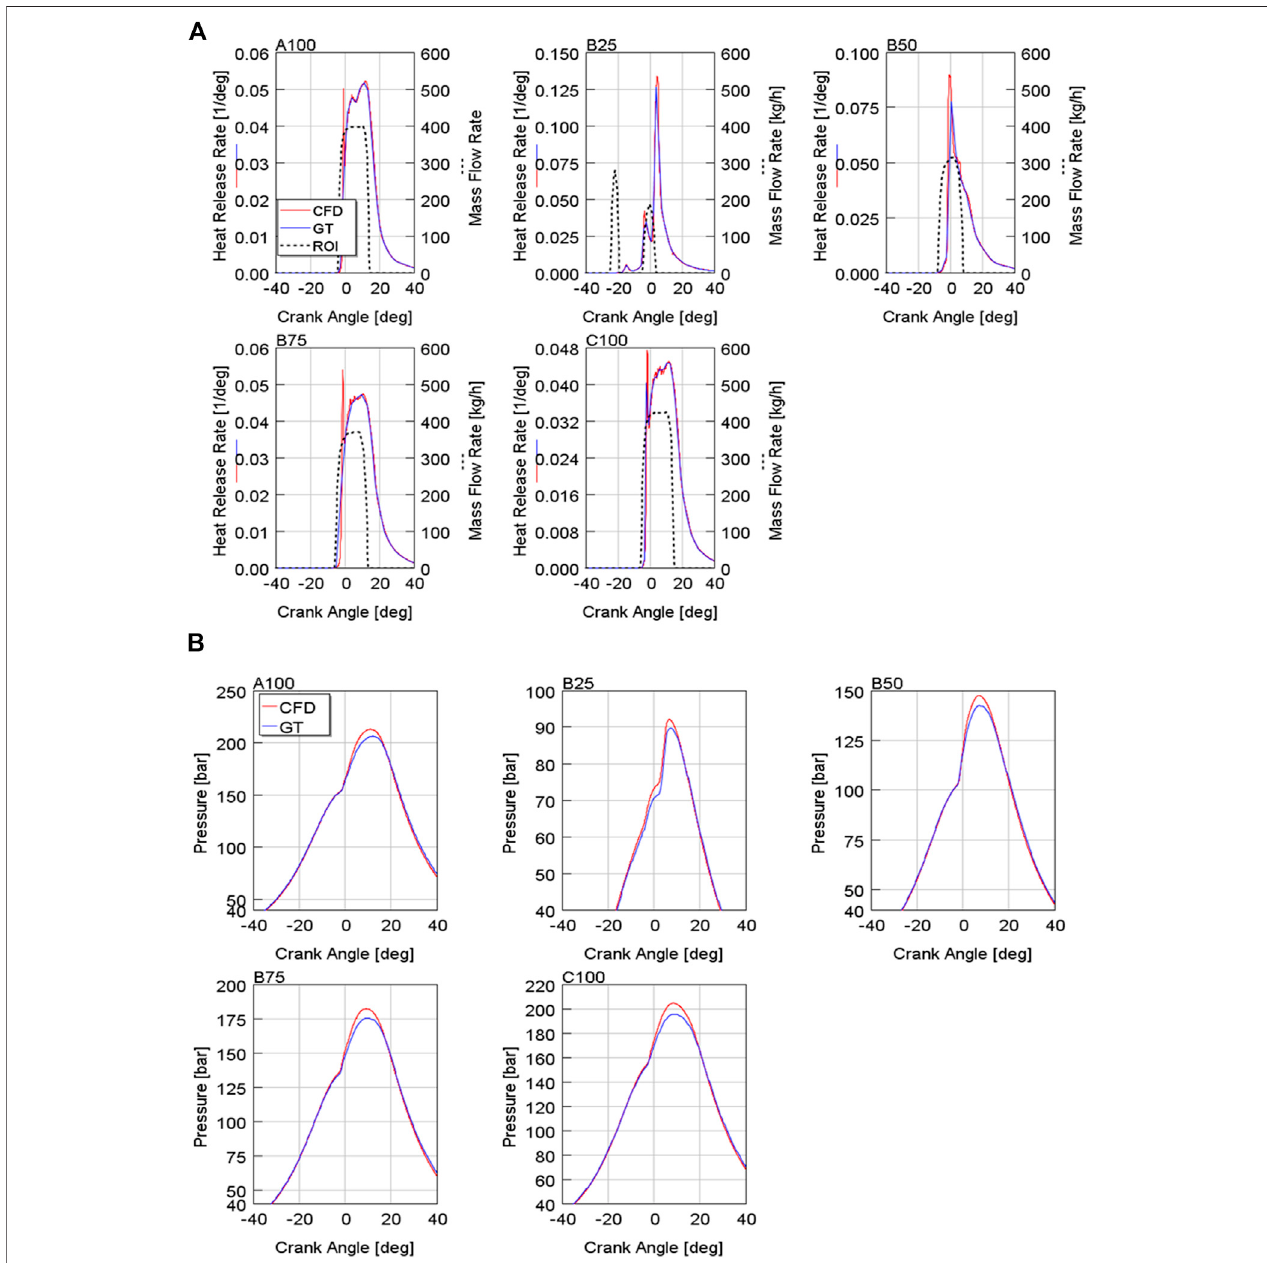
FIGURE 4 | (A) CFD generated burn rate and normalized rate of injection pro fi les and (B) In-cylinder pressure traces match between 3-D CFD and 1-D for RON80 at CR16.5. (NOx (cid:1) 1 – 1.5 g/kWh).